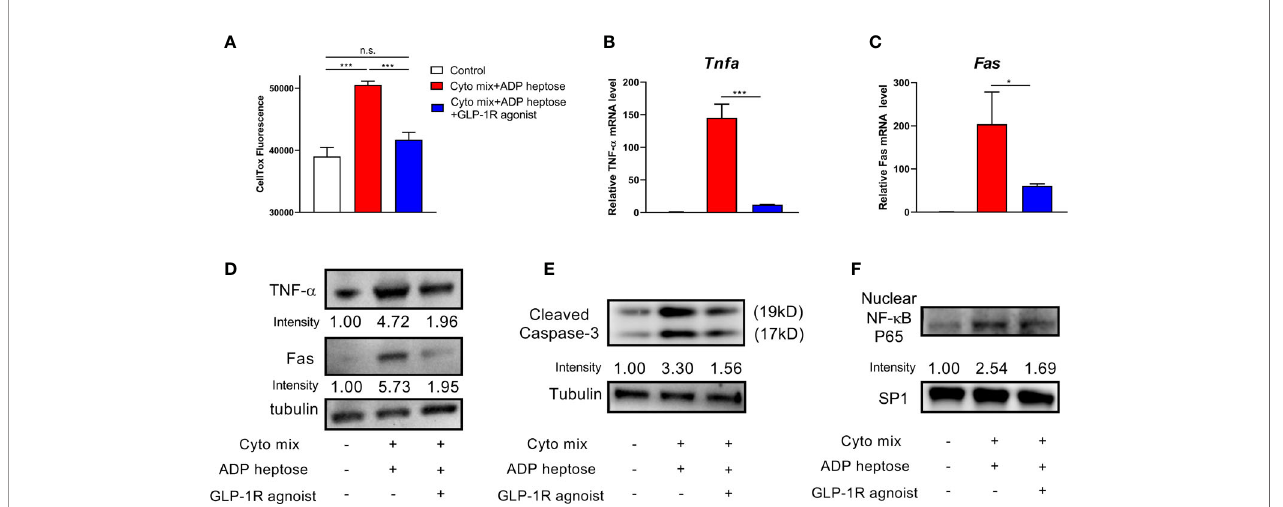
FIGURE 5 | GLP-1R agonist ameliorated apoptosis in beta cells exposed to ADP heptose and cyto mix. (A) The death of MIN6 cells as assayed by the staining of CellTox Dye. The changes of mRNA (B, C) and protein (D) levels of TNF- a and Fas when cyto mix and ADP heptose treated MIN6 cells exposed GLP-1R agonist (100 nM) for 24 hours. (E) The level of cleaved Caspase-3 was examined by western blotting. (F) The nuclear proteins of MIN6 cells were fractioned, and the level of NF- k B P65 was detected by western blotting. The nuclear protein SP1 was served as the internal control. Data show mean ± SD and are representative of 3 independent experiments. The data shown in (A – C) were analyzed with unpaired Student ’ s t-test *P < 0.05; ***P < 0.001; n.s., not signi fi